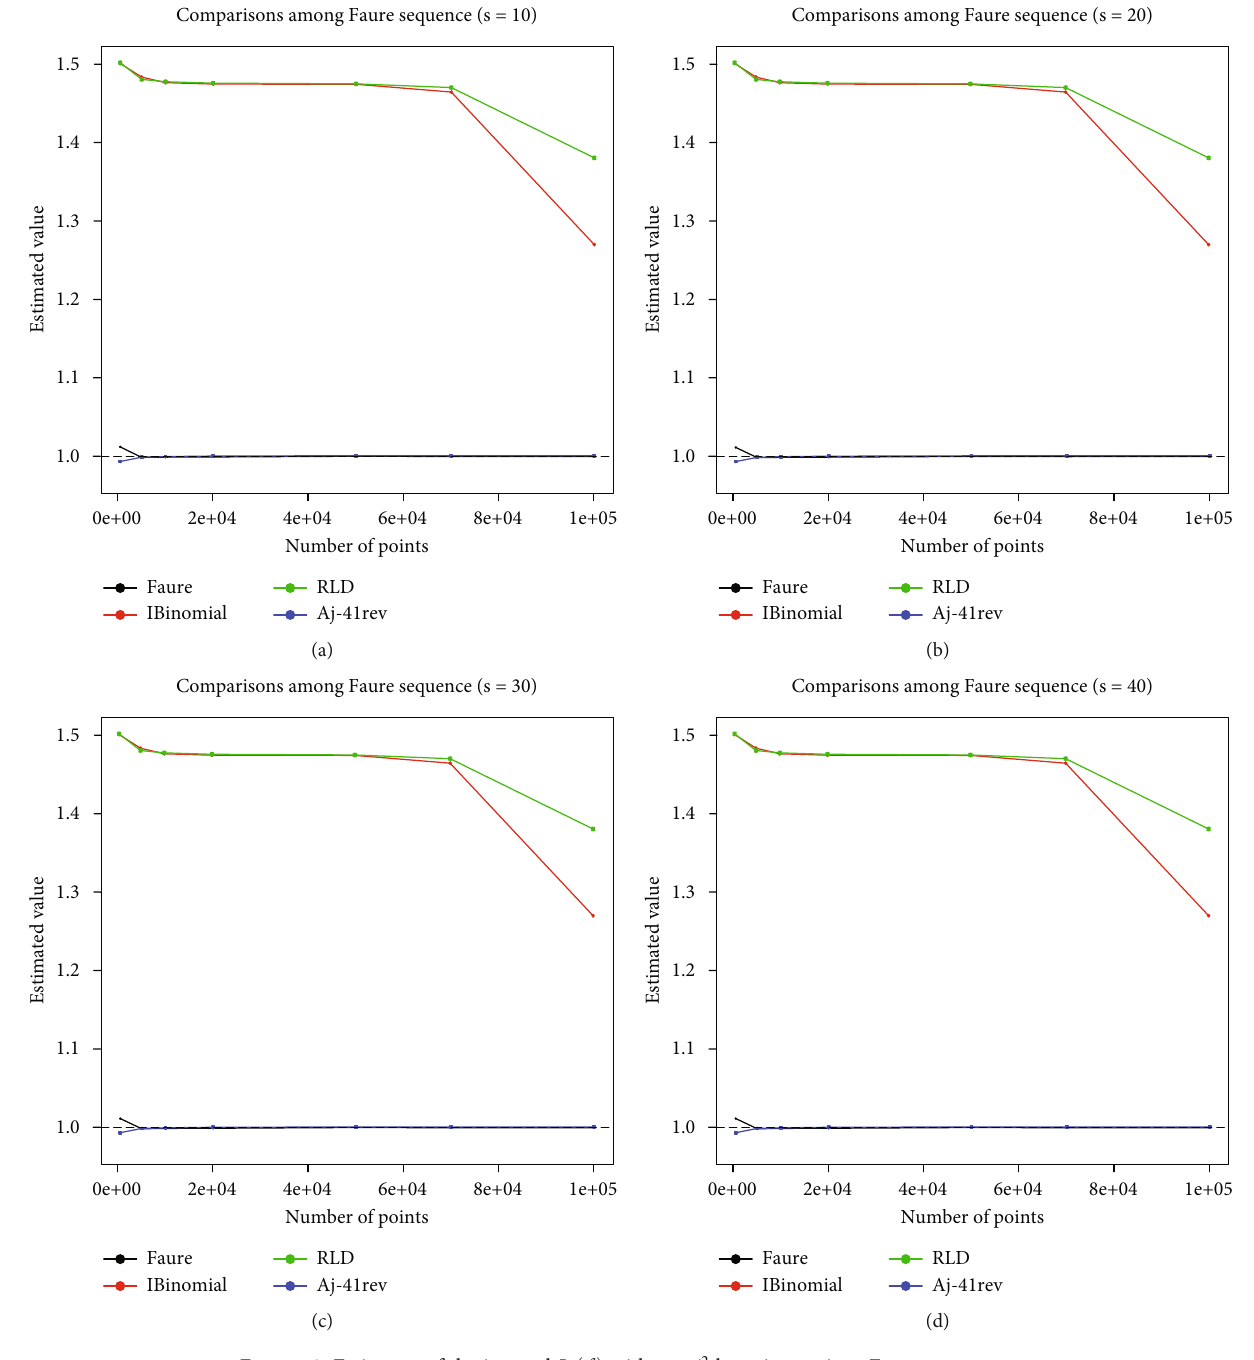
ð f Þ with a = i 2 by using various Faure 2 i